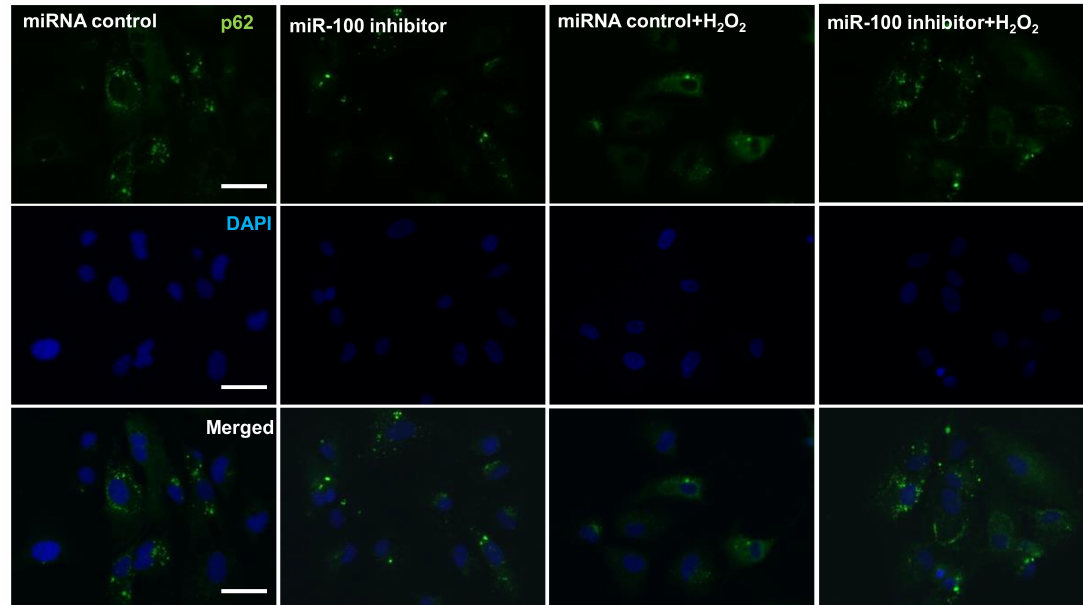
Figure 7. Effects of miR-100 inhibition on cellular expression and distribution of p62 in human ARPE-19 cells under oxidative stress. ARPE-19 cells were transfected with either miR-100 inhibitor or miRNA control nucleotides for 24 h followed by H 2 O 2 exposure at 225 µ M for another 24 h. Afterward, the cells were fixed and subjected to immunofluorescent staining. Note that miR-100 inhibition restored autophagy-associated perinuclear granules in the H 2 O 2 -exposed cells. Scale bar = 20 µ